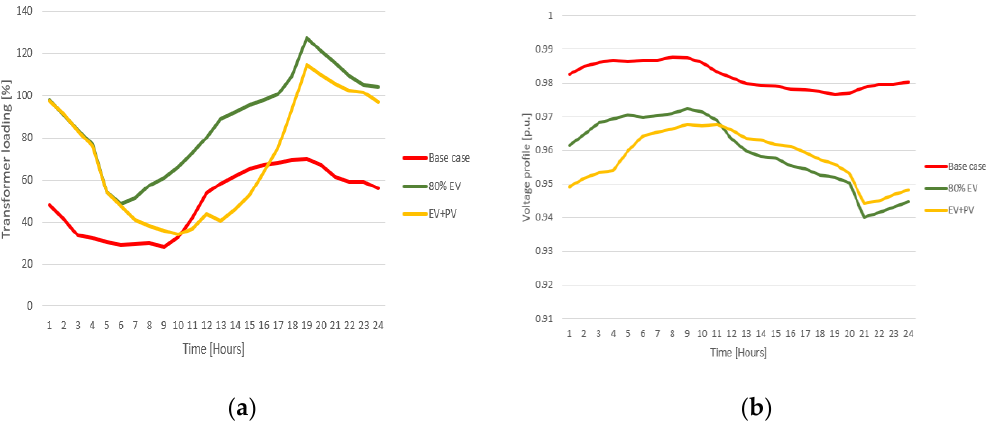
Figure 16. Comparison of rural ( a ) transformer loadings and ( b ) most loaded feeder voltage profiles